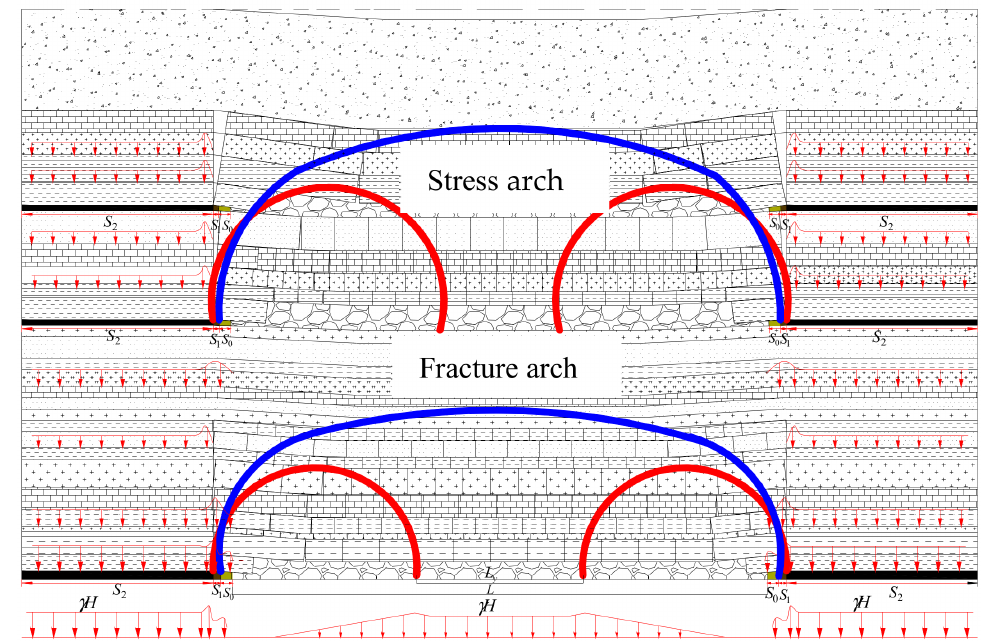
Figure 3. Overburden structure map of the study